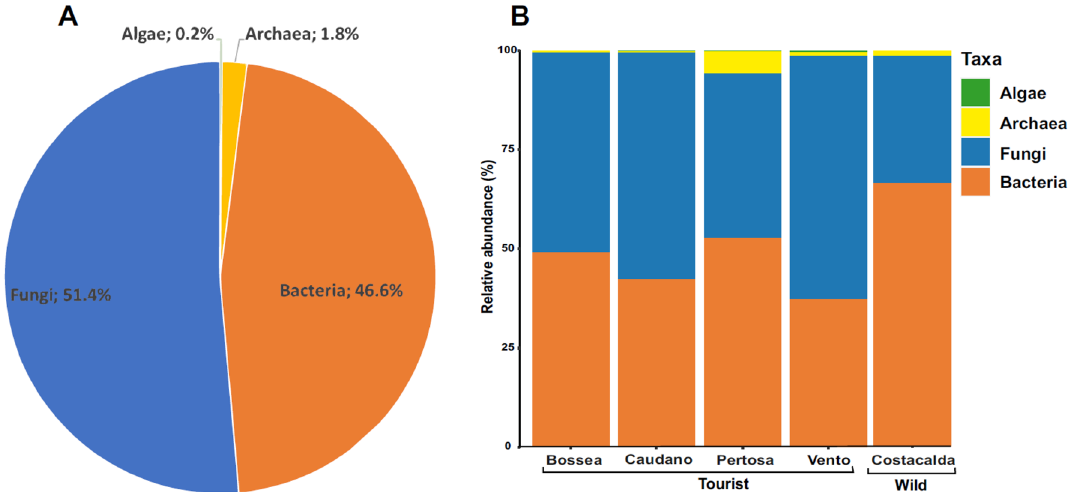
Figure 1. Total microbial cave community composition: as a unique dataset ( A ) and per single cave perspective ( B